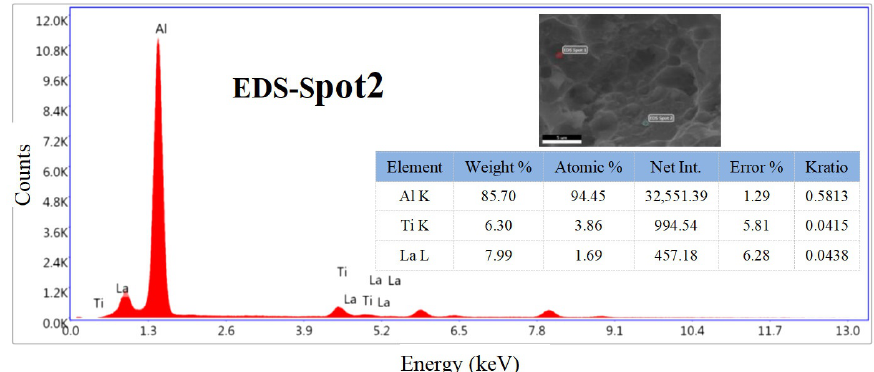
Figure 7. EDS results of the red area B in Figure 6b.